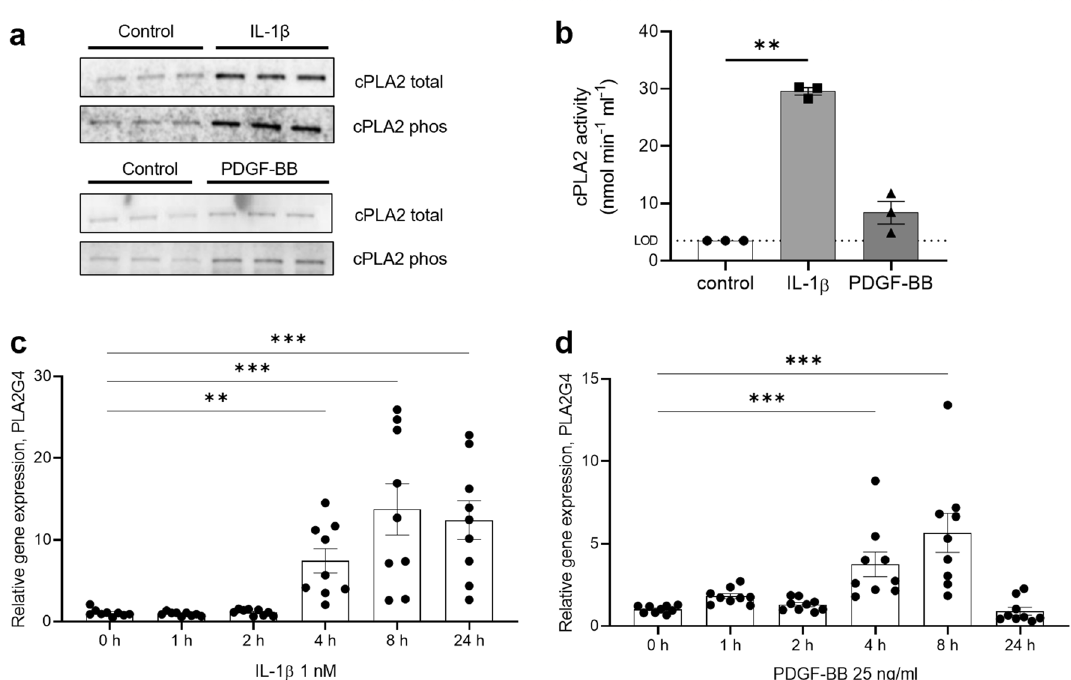
Figure 4. Activation of rate-limiting enzyme cPLA2, upstream of COX-2. Phospholipase cPLA2 is upregulated and phosphorylated in human mesangial cells after 24 h stimulations with IL-1β and PDGF-BB ( a ). cPLA2 activity is accordingly increased ( b ). The activity in the controls was below the LOD of 3.5 nmol/min/ml. In this case, the LOD value was plotted in the graph. PLA2G4A gene expression was already upregulated after 4 h in both treatments ( c , d ). * P < 0.05; *** P < 0.001. Data are reported as mean ± SEM. Uncropped blots after chemiluminescence development and total protein stain free blots are presented in Supplementary Fig. S4d. Quantification of the bands in the western blot is reported in Supplementary Fig.